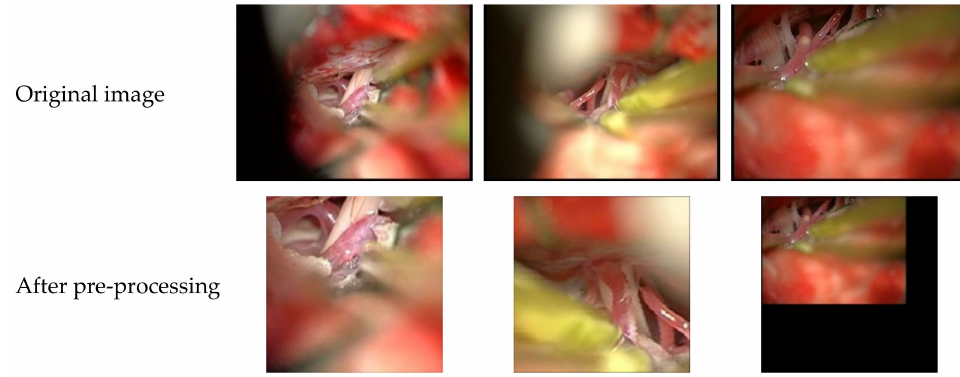
Figure 6. Examples of pre-processing.